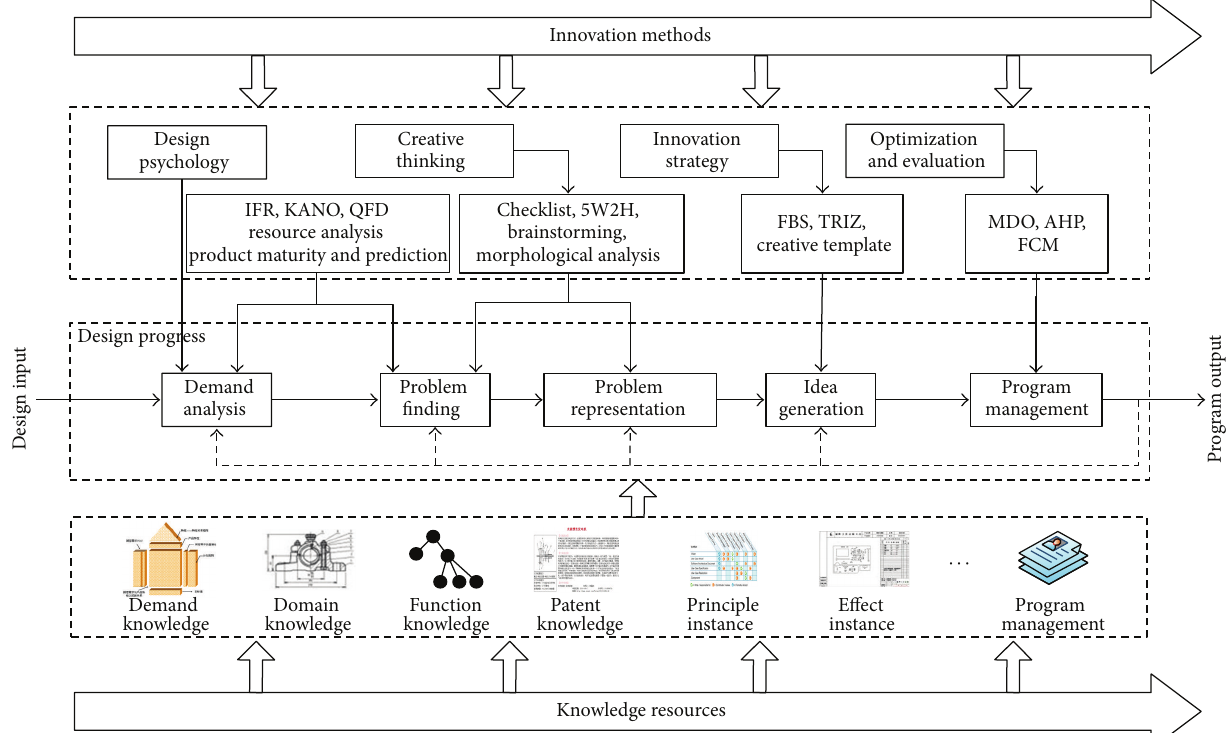
Figure 3: The application model of knowledge resources